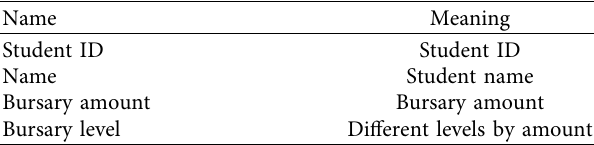
Table 5: Student financial aid data.